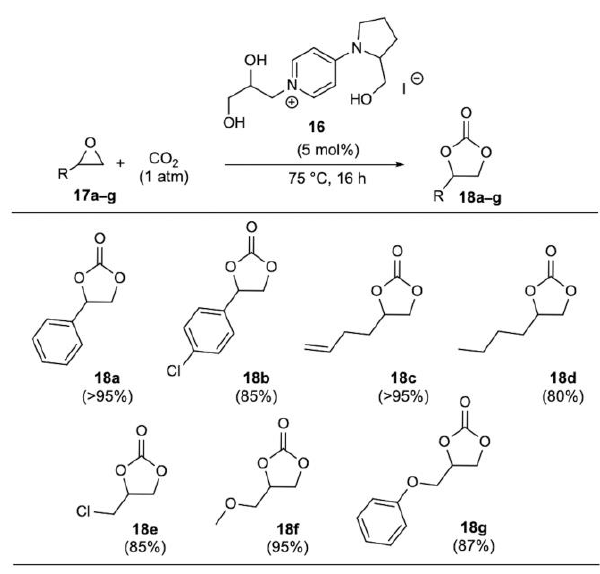
Scheme 4. Substrate scope (batch